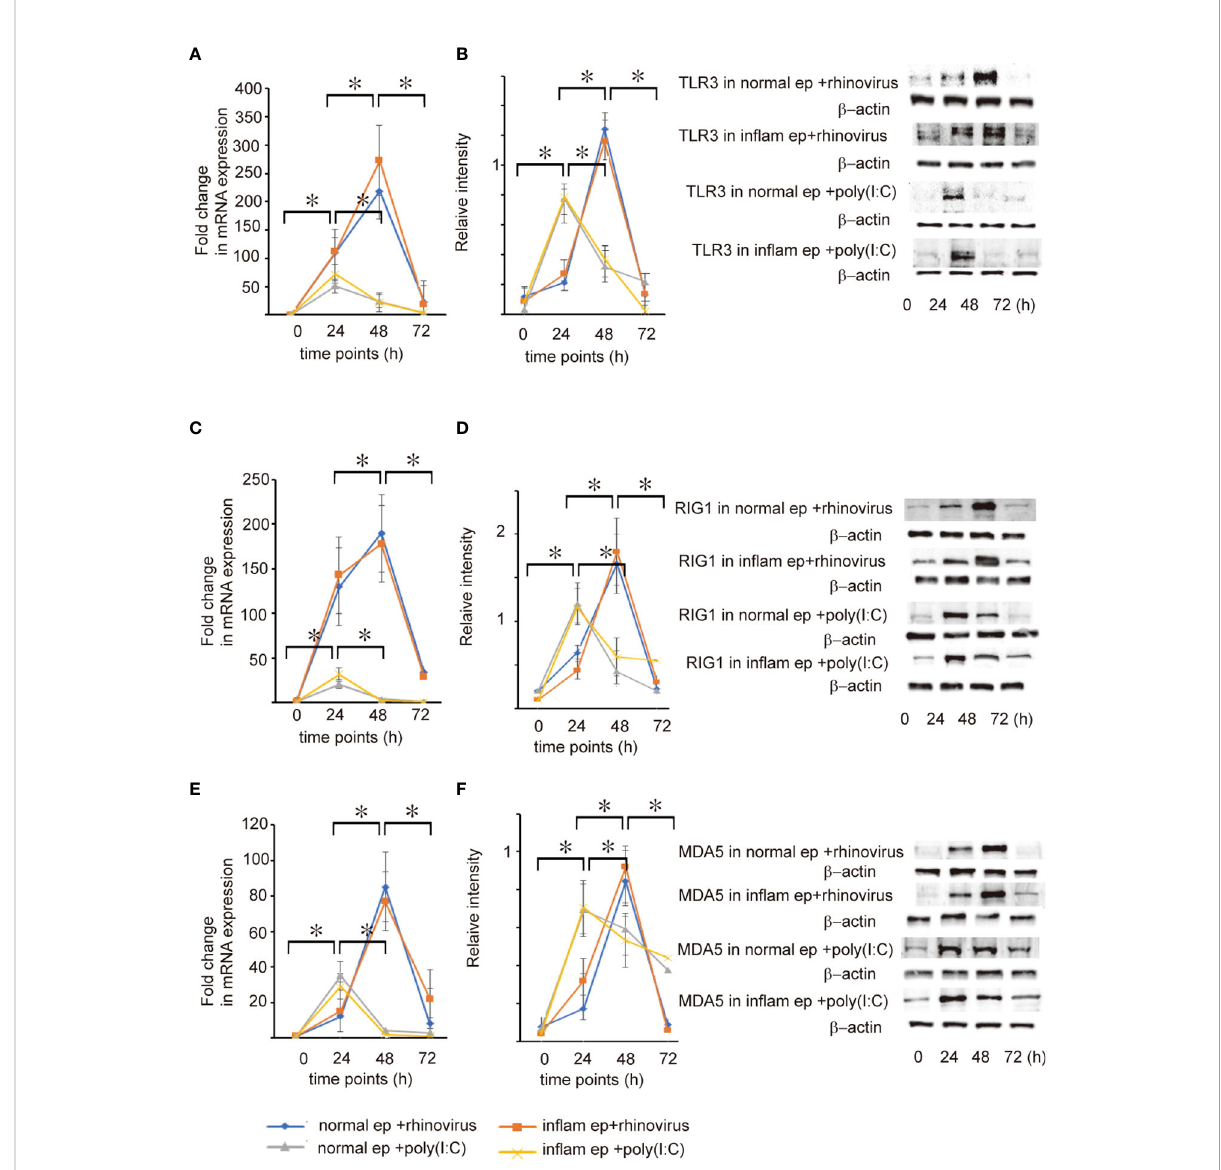
FIGURE 4 The expression level of TLR3 (A, B) , RIG-I (C, D) , and MDA5 mRNA (E, F) and protein expression in cultured normal and in fl ammatory sinonasal epithelial cells obtained from healthy control and patients with CRSwNP, respectively. Their levels were evaluated 24, 48, and 72 h after RV 16 inoculation and poly(I: C) treatment, which were evaluated by RT – qPCR (A, C, E) and western blot (B, D, F) . Right panels located in the fi gure show representative protein bands evaluated with western blot. Data are mean ± SEM from 7 different epithelial donors. Normal ep + rhinovirus indicates that cultured normal epithelial cells were infected with RV 16. In fl am ep + rhinovirus indicates that cultured in fl ammatory epithelial cells were infected with RV 16. Normal ep + poly (I: C) means poly(I: C)-treated cultured normal epithelial cells. In fl am + poly (I:C) means poly (I:C)-treated cultured in fl ammatory epithelial cells. * indicates a signi fi cant difference between each